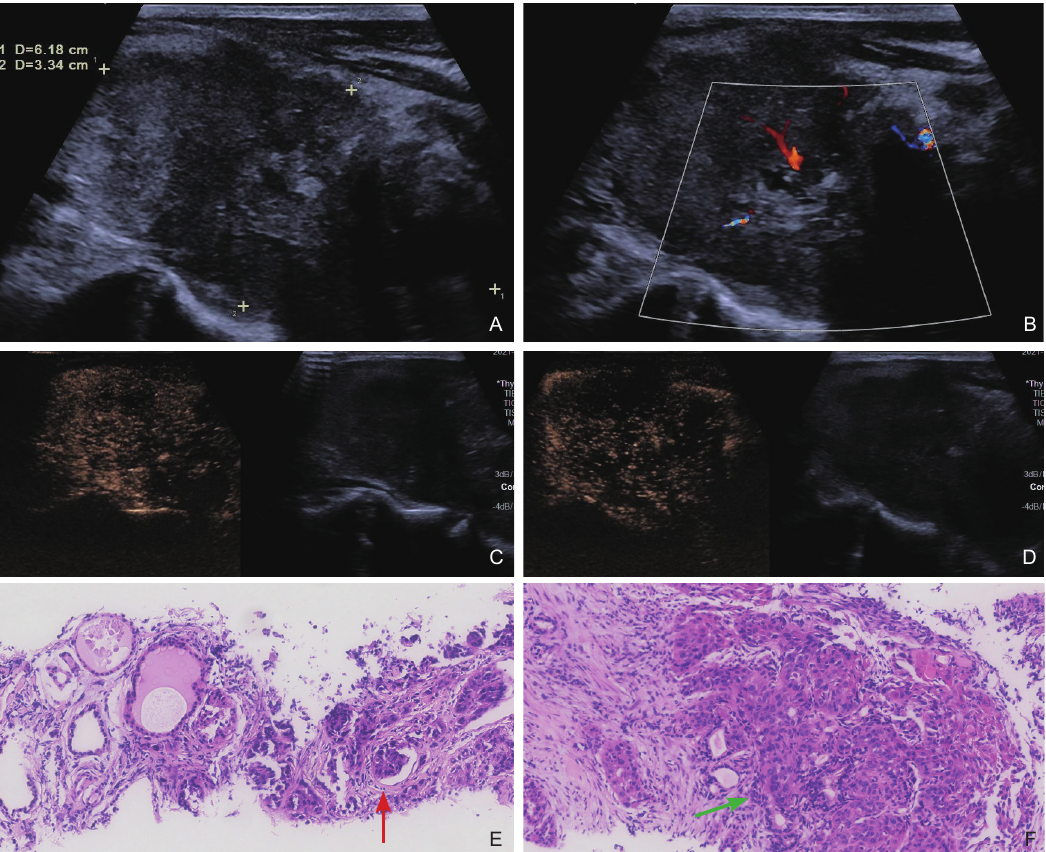
Figure 2 Conventional US and CEUS findings in case two. (A) Two-dimensional US showed a hypoechoic mass in the right lobe of thyroid, with unclear margin and irregular shape; (B) Rich and irregular blood flow signals were detected in and around the mass; (C) CEUS showed irregular low enhancement at 18s of arterial phase, and the tumor boundary was more clear than two-dimensional US; (D) CEUS showed rapid washout of the mass (20s); (E) HE staining, 200 × magnification (red arrow indicated squamous-cell carcinoma); (F) HE staining, 200 × magnification (green arrow indicated squamous-cell